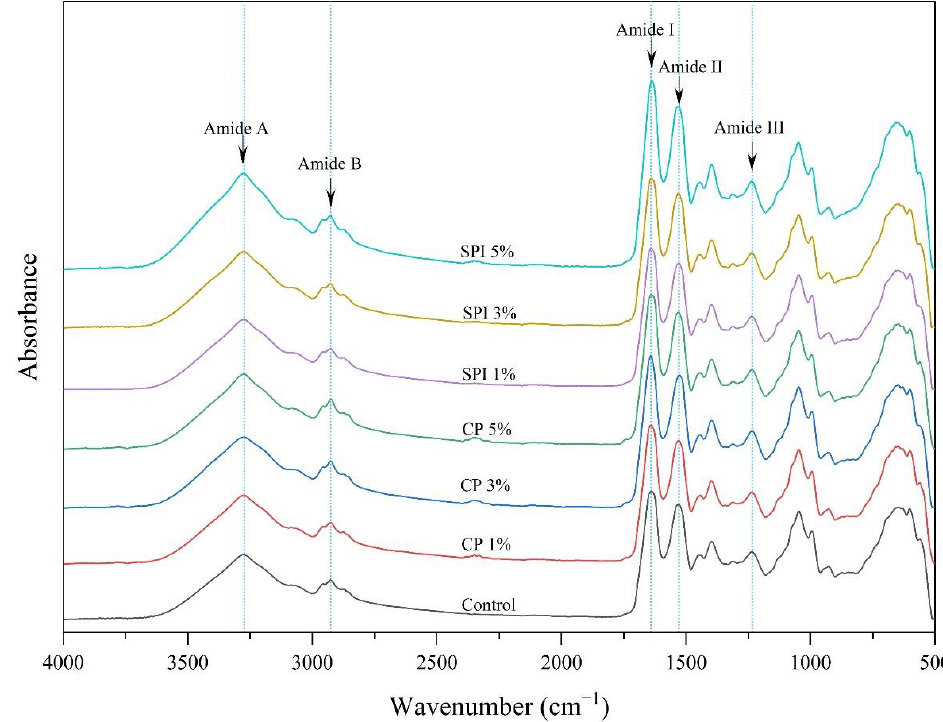
Figure 4. FTIR spectra of surimi gels with the addition of cricket powder (CP) and soy protein isolate (SPI) at different levels.